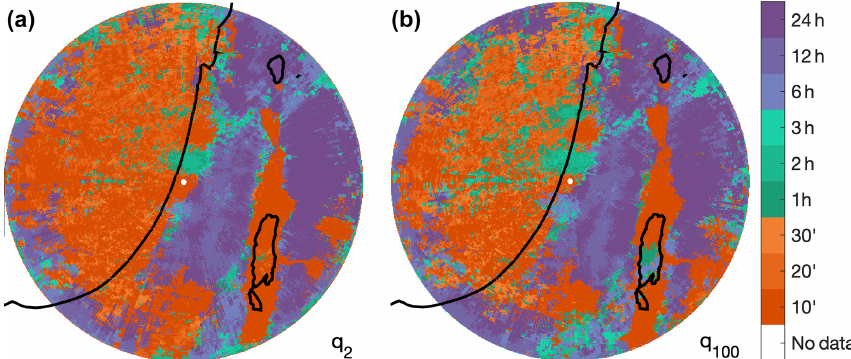
Figure 10. Durations at which the local 2- (a) and 100-year (b) return levels are the strongest. At each duration, intensities are ranked among all pixels so as to associate 1 to the largest value over the region and 0 to the smallest. The maps display the duration which, at each pixel, has the largest